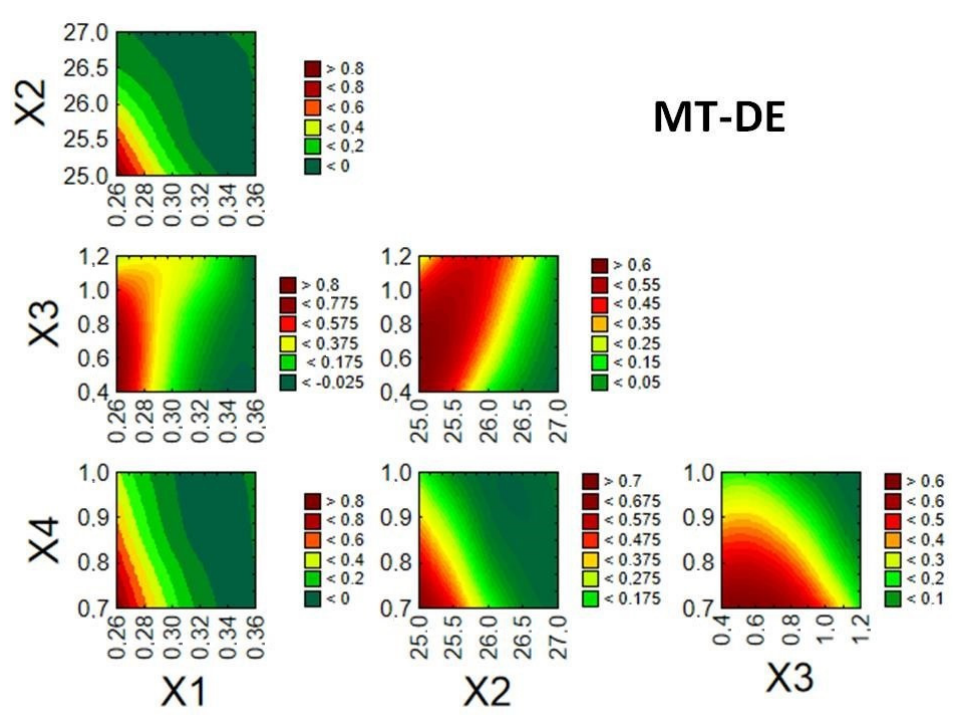
Figure 6. Desirability plots for response surface predictions of MT-DE showing the interactions between factors X1–X4.